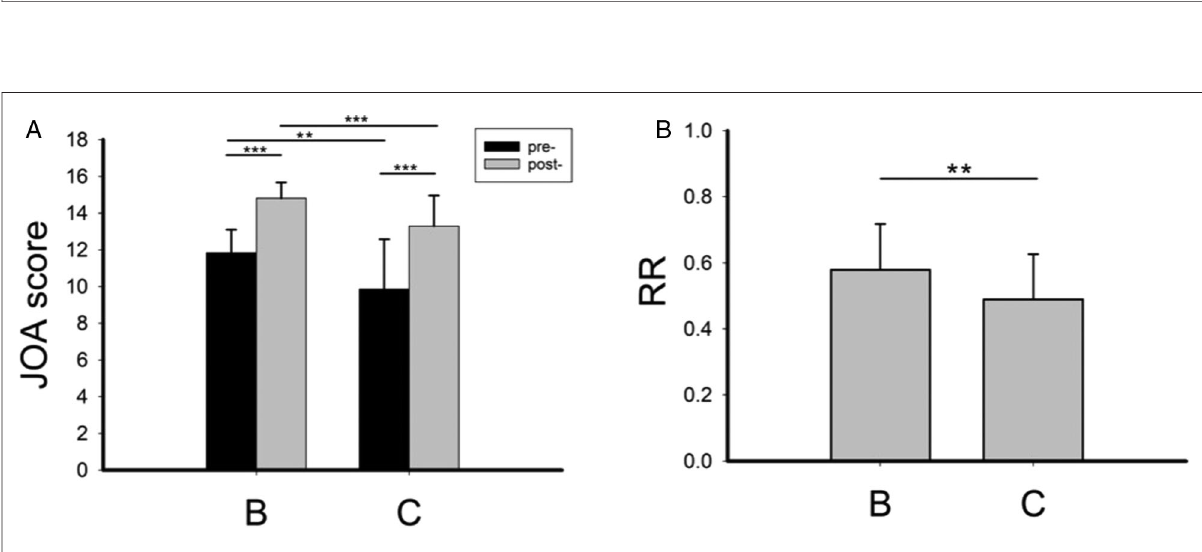
FIGURE 3 The preoperative and postoperative JOA score ( A ) and postoperative recovery rate ( B ) in group B and group C. RR, recovery rate. ** P <0.01; *** P <